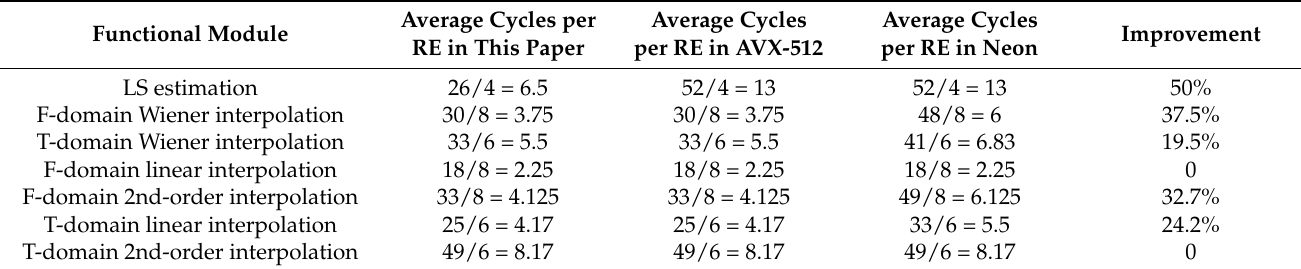
Table 4. Comparison of instruction efficiency for the channel estimation